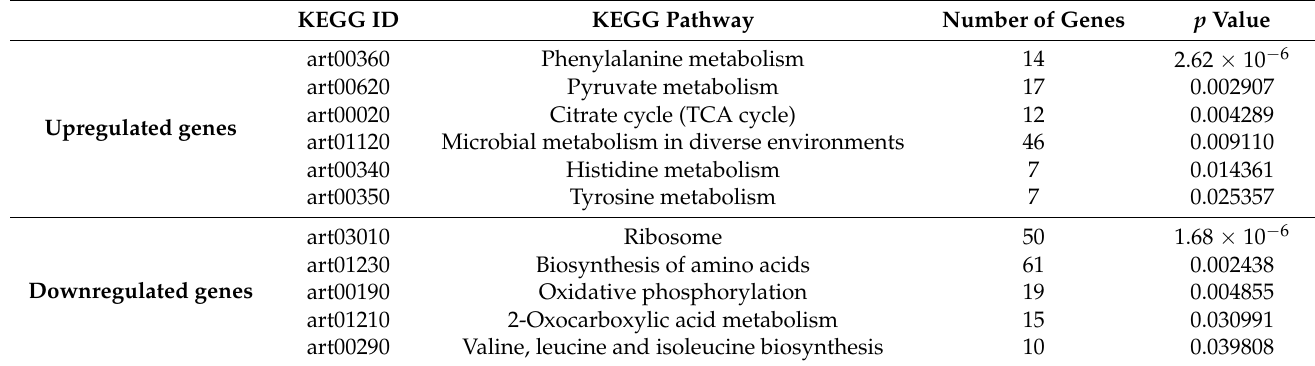
Table 2. Top enriched KEGG pathways of the differentially expressed